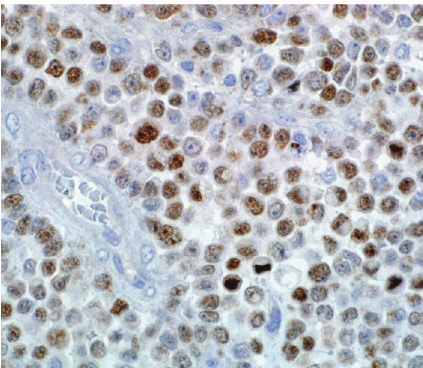
Figure 3: Weak-to-moderate ER nuclear expression of the tumor cells (ER immunohistochemical stain, magnification power ×